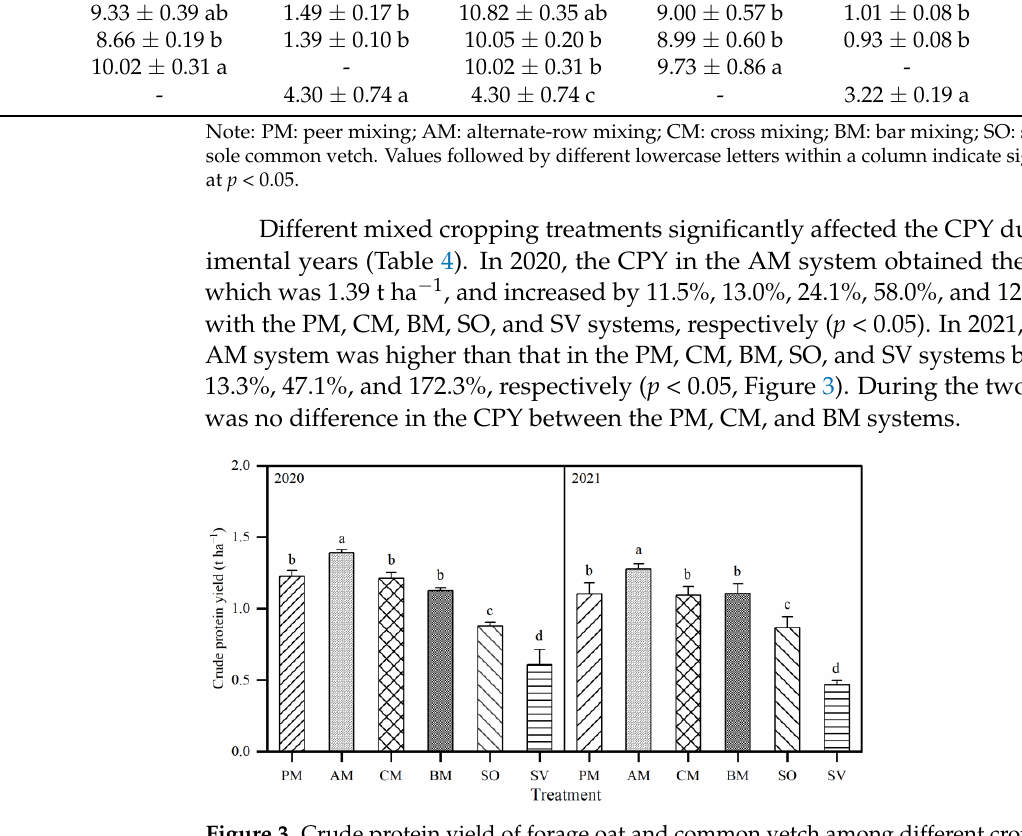
Figure 3. Crude protein yield of forage oat and common vetch among different cropping systems in two years in Yanchi County, Ningxia, China. Note: PM: peer mixing; AM: alternate-row mixing; CM: cross mixing; BM: bar mixing; SO: sole forage oat; SV: sole common vetch. Different lowercase letters indicate significant difference at p <